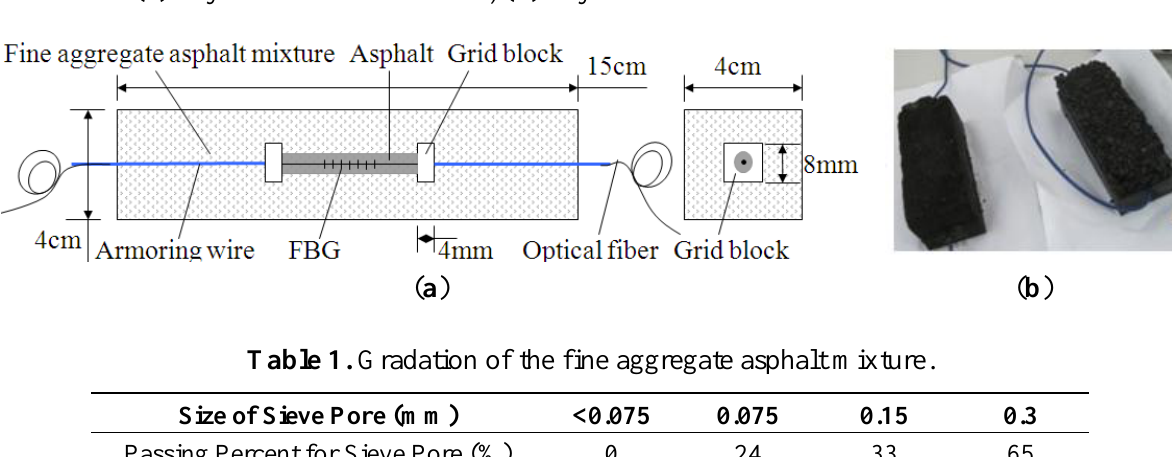
Figure 4. A sketch and actual photo of a fine aggregate-asphalt mixture packaged FBG sensor. ( a ) Layout of the FBG sensor; ( b ) Physical model.